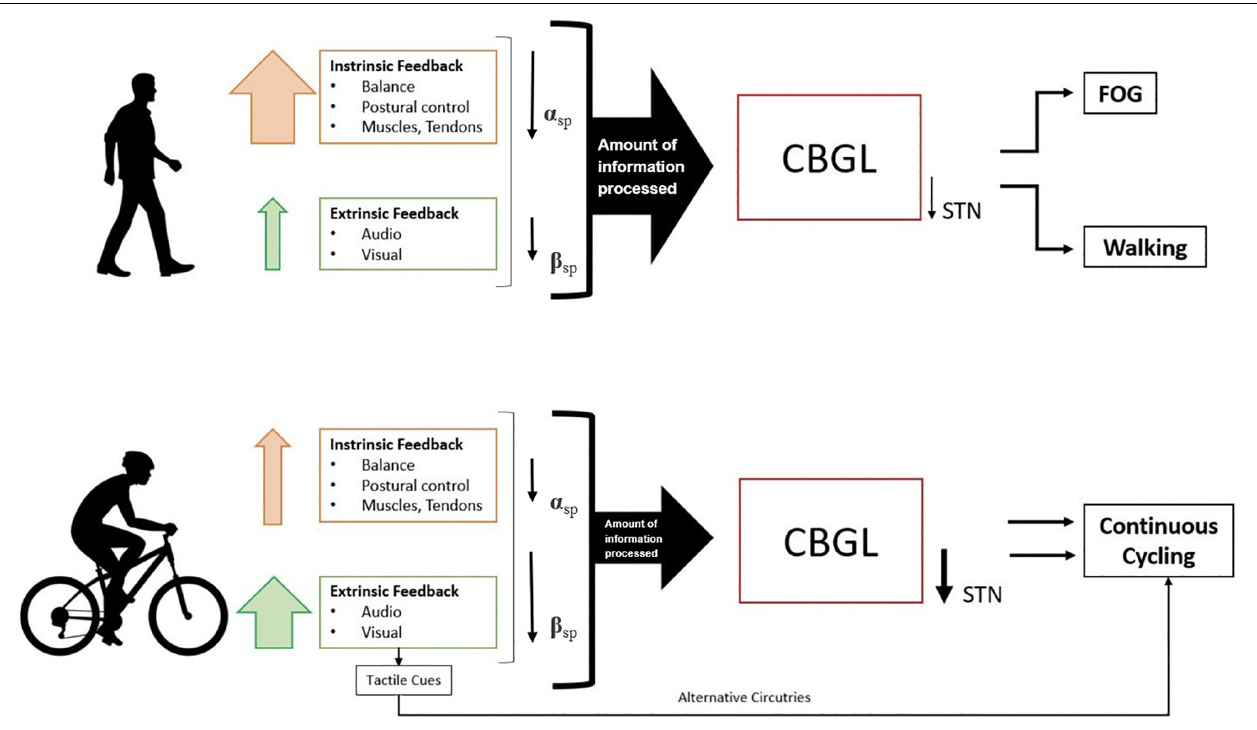
FIGURE 1 | Differences in information processing and brain oscillations during initiation and continuous movement in walking and cycling. α sp = alpha-band suppression; β sp = beta band suppression, CBGL, cortico-basal ganglia loop; STN, subthalamic nucleus; FOG, freezing of gait. The size of the arrow presents the degree of